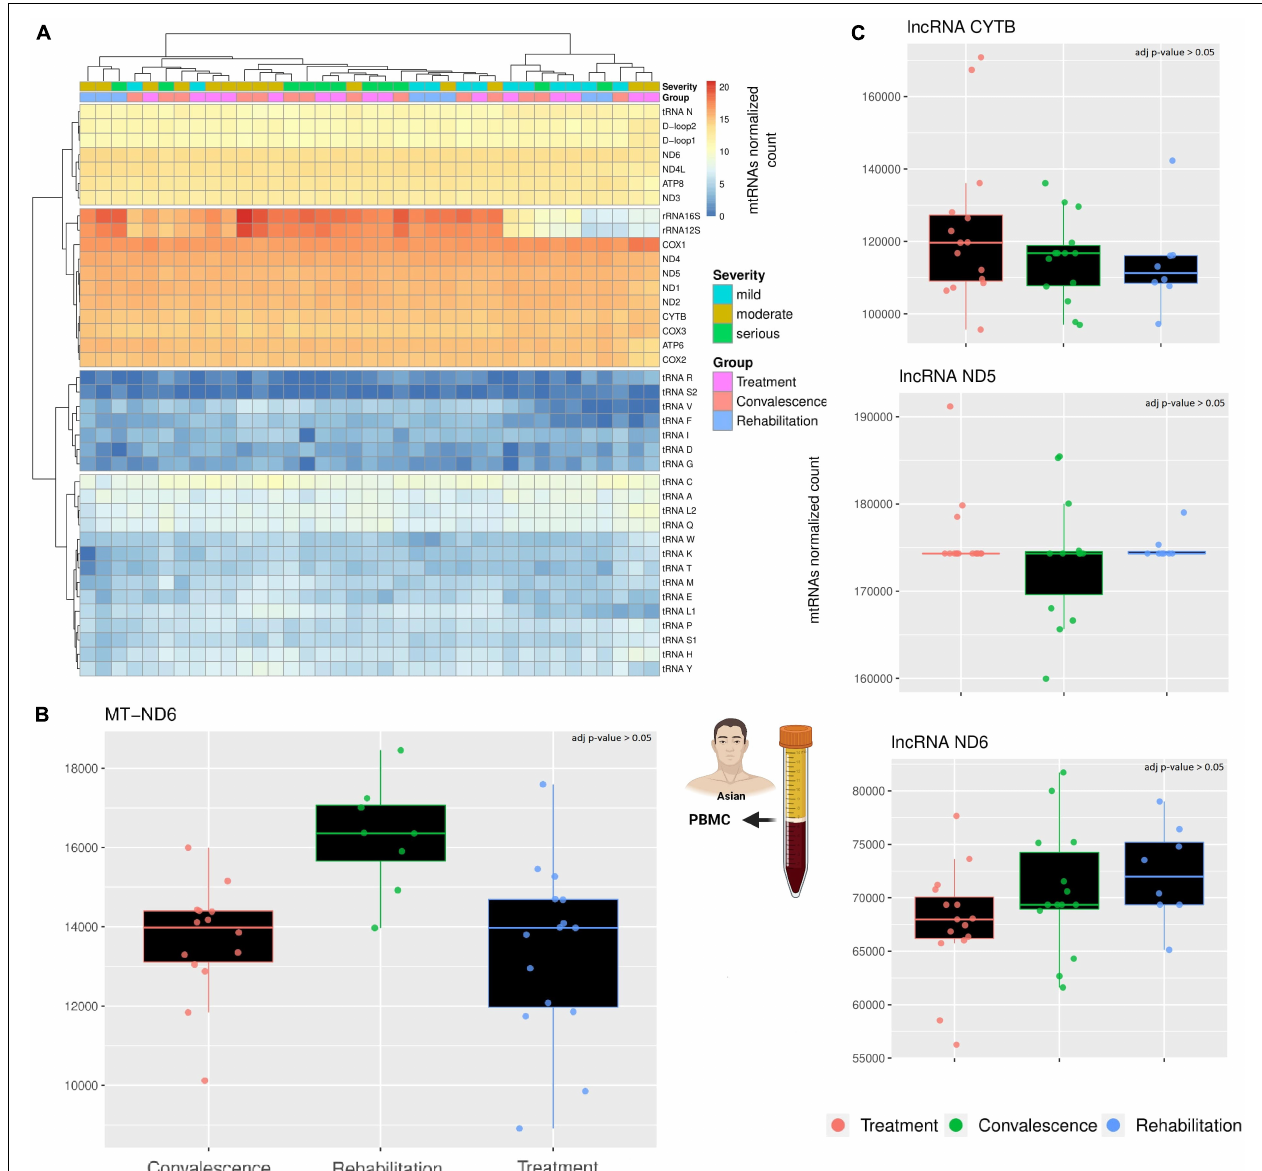
FIGURE 1 | A comparison across three clinical stages of long RNAs expression. (A) The heatmap compare the expression of canonical genes encoded on the mitochondrial genome. The rows represent mitochondrial genes, while the columns are individuals. Each individual has annotated the severity of the COVID-19 infection and the stage when their blood sample was taken. According to the different level of expression, ranging from blue to red, four clusters can be identified. Both columns and rows have been clustered. (B) The barplot compare the expression of MT-ND6 mRNA across three clinical stages. Each datapoint in a single clinical stage (e.g., Treatment) represent a different patient, furthermore, the patients are the same across the three clinical stages. (C) The barplots compare the expression of three lncRNAs across three clinical stages using the same criteria of the previous barplot. The icons in the figure highlights from which population and type of sample the data are generated. The icons have been made using